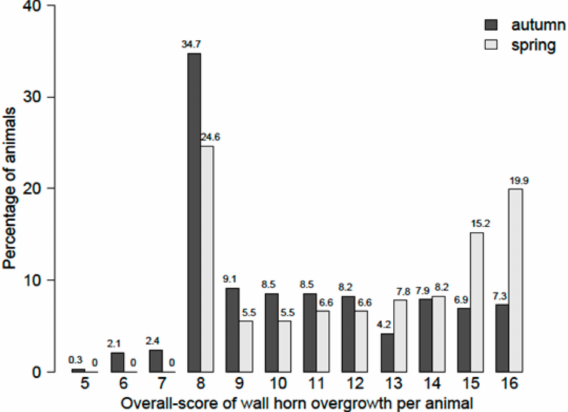
Figure 2. Distribution of the overall score of wall horn overgrowth per animal in autumn and spring. The analysis of the effects of housing and management factors on wall horn over- growth revealed that the overall score per animal was associated with the factor “INT (season + alpine pasture)” ( p < 0.001; Figure 3). Goats that grazed on alpine pasture in summer showed less overgrowth compared with goats that did not graze on alpine pasture in summer and compared with all goats in spring. Furthermore, the model showed a correlation with “time span since last trimming” ( p < 0.001; Figure 4). The more time had passed since the last trimming, the more wall horn overgrowth appeared. No association was found with “herd size” ( p = 0.72) and “special skills training” ( p =